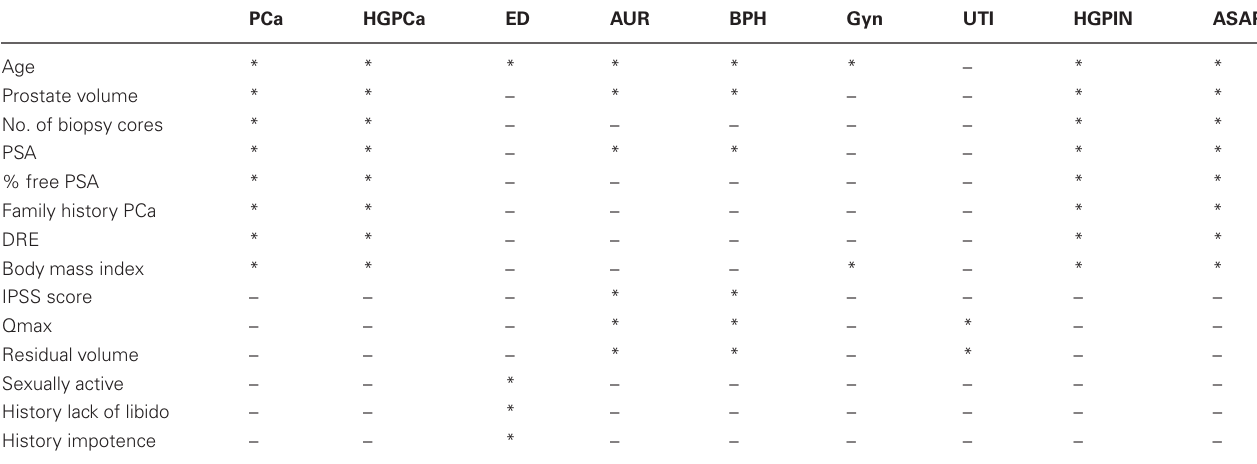
Table 1 | Predictor variables included in each